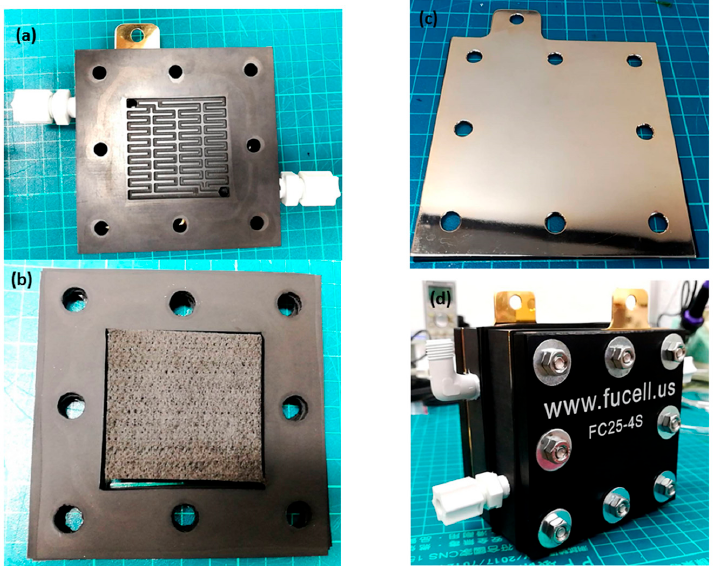
Figure 6. Proton battery. ( a ) Bipolar plate. ( b ) MEA. ( c ) Metal current collector plate. ( d ) Finished product.